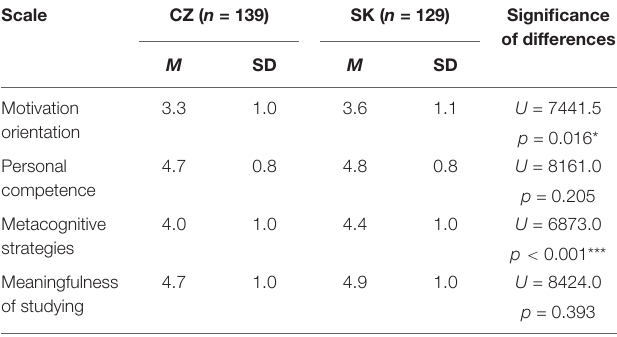
TABLE 4 | An overview of the analysis by